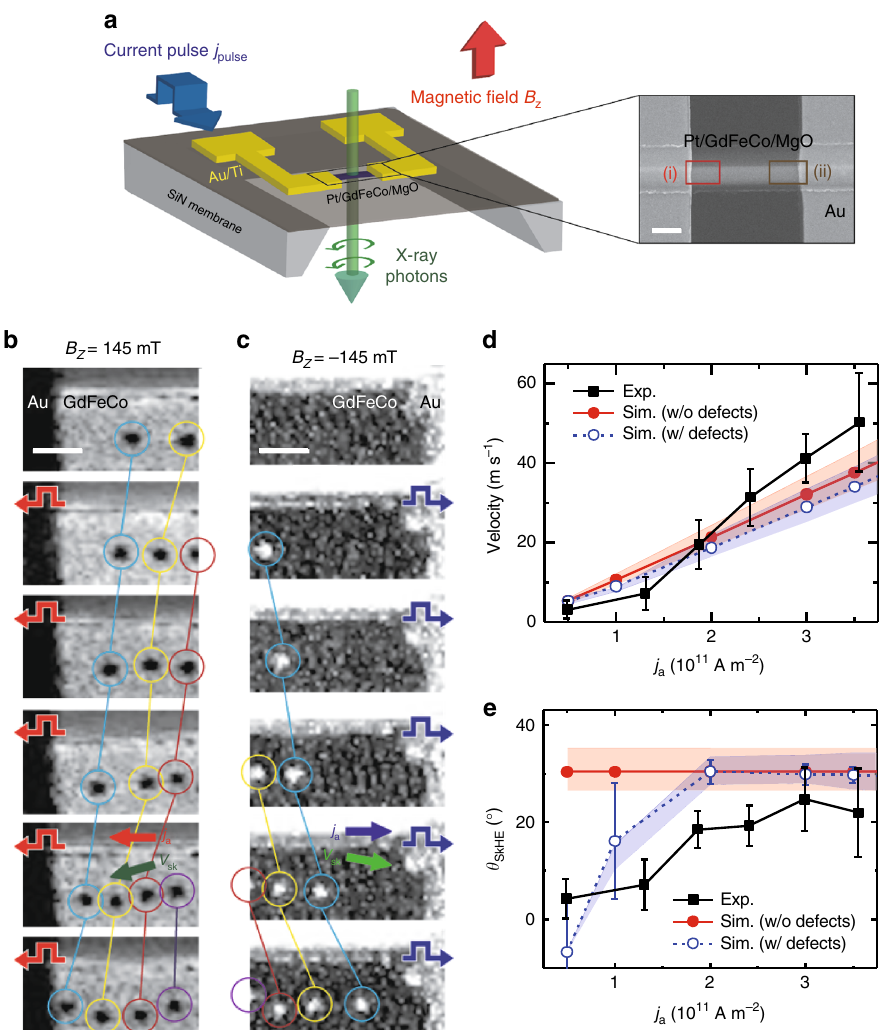
Fig. 2 Current-driven behavior of ferrimagnetic skyrmions and their velocity and skyrmion Hall effect. a Schematic of scanning transmission X-ray microscopy (STXM) geometry, and a scanning electron microscopy (SEM) image of the actual device used for experiments. Scale bar, 2 μ m. Sequential STXM images taken at Fe-edge showing the responses of multiple skyrmions after injecting unipolar current pulses along the track at b B z = 145mT and c B z = − 145mT, respectively. With a fi xed pulse-length of single pulse, 5ns, the pulse amplitude is changed between 4.90×10 10 Am − 2 ≤ | j a | ≤ 3.55×10 11 Am − 2 . Pulse polarities are indicated as red- and blue-colored arrows inside each image. Within STXM images, the same skyrmion is indicated with the same color. Scale bars, 500nm. d Experimental and simulated average skyrmion velocity of Pt/GdFeCo/MgO versus current density. e Experimental and simulated average skyrmion Hall angle of Pt/GdFeCo/MgO versus current density. Experimentally measured skyrmion Hall angles were converted into their absolute value. In d , e The shaded areas in plots represent the simulation results considering the damping coef fi cient error ranges of α = 0.205±0.035, which was measured experimentally as described in Supplementary Fig. 3 and Supplementary Note 3. Note that pulse current densities above ~4×10 11 Am − 2 led the damage of the Au contact, which eventually limited the maximum applicable current to our sample. Error bars denote the standard deviation of multiple